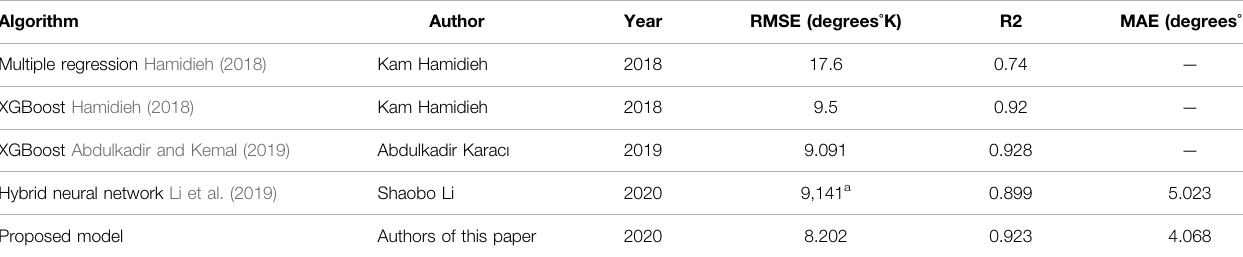
TABLE 5 | Compilation different